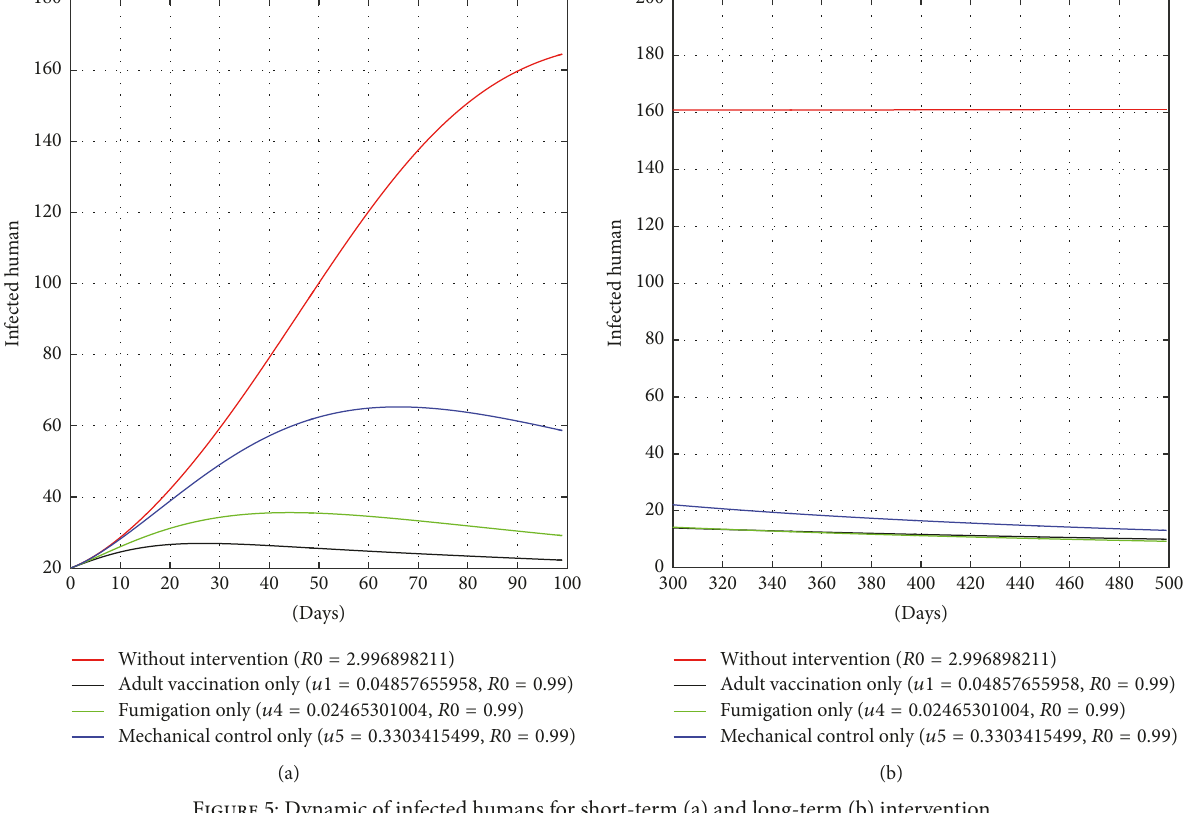
Figure 5: Dynamic of infected humans for short-term (a) and long-term (b) intervention.